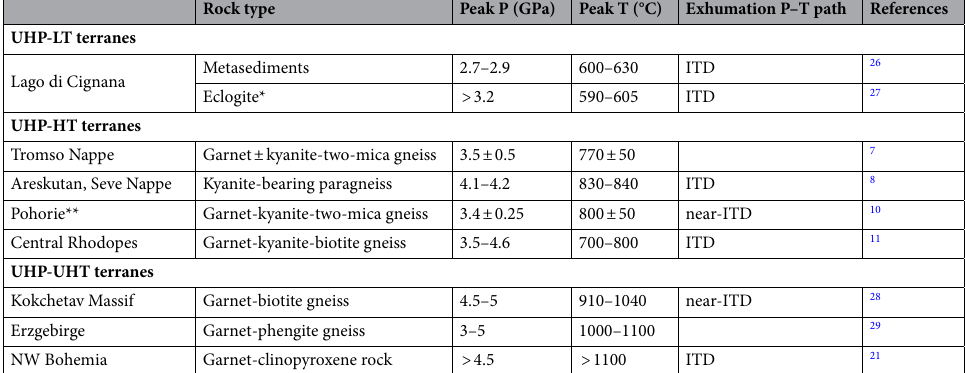
Table 2. Summary of peak P–T estimates and retrograde paths for diamond-bearing metasediments worldwide. ITD isothermal decompression. *Peak P–T estimate used in Fig. 4 coming from the associated diamond-free rocks. ** Peak P–T conditions within the range comparable to those of the associated eclogites.